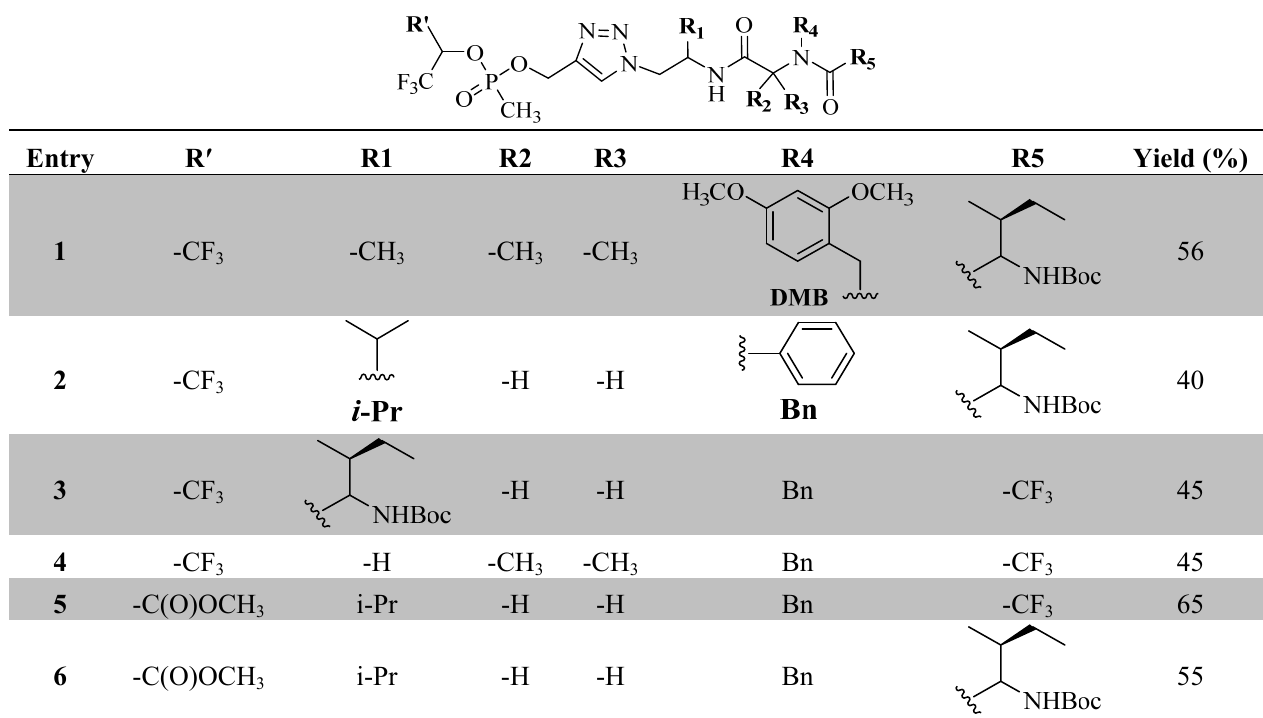
Table 1. Selected fluoronated OPI-peptide constructs linked via CuAAC